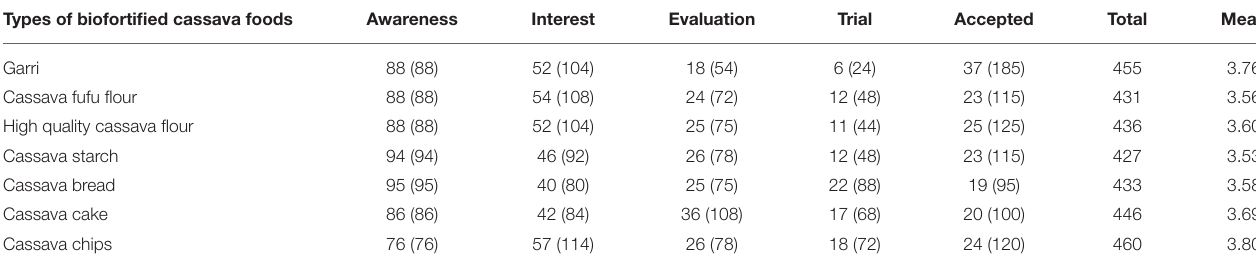
TABLE 1 | Level of adoption of value-added biofortified cassava products. Types of biofortified cassava